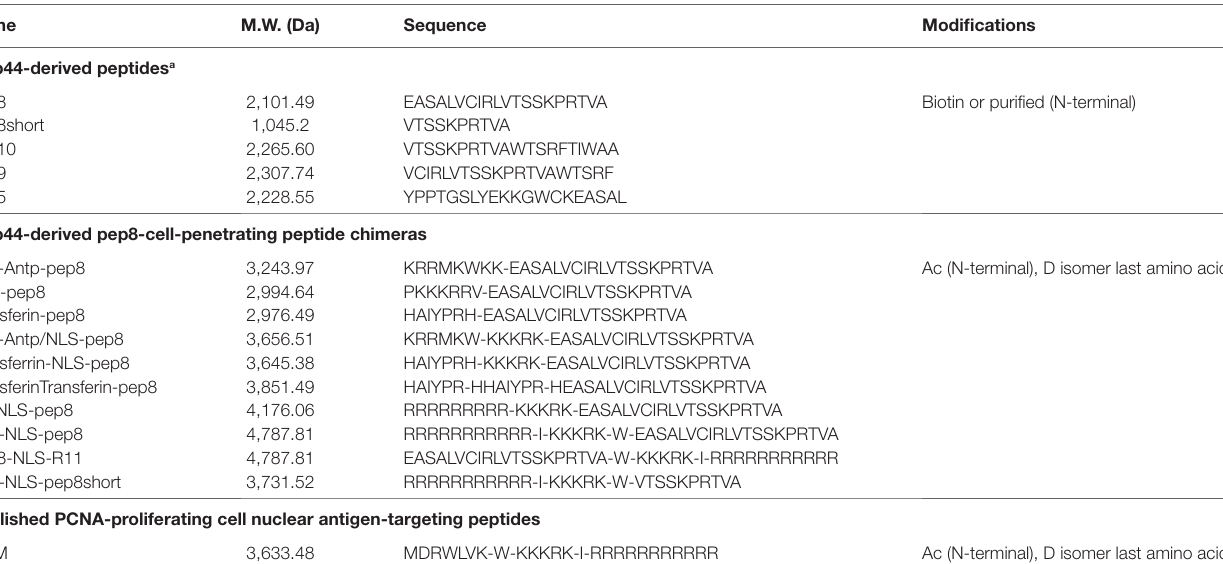
TaBle 1 | Amino acid sequences of peptides employed in this